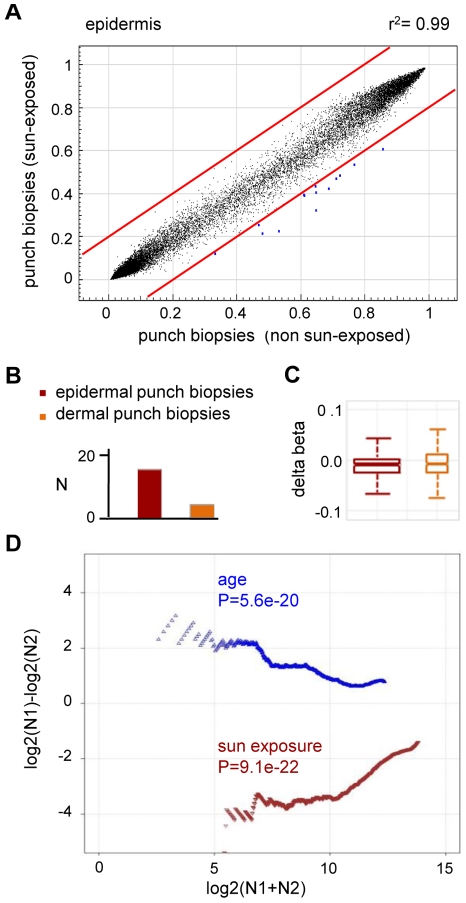
Sun exposure-related hypomethylation.(A) Average epidermal DNA methylation profiles of the study population were compared between 10 sun-exposed and 10 non-exposed epidermis samples. The results reveal a distinct trend towards sun exposure-related hypomethylation. (B) Barplot illustrating the results from an independent statistical analysis of the array data. Bars indicate the number of substantially hypomethylated (Δ(beta)≤−0.2, P(BH)<0.01) markers. (C) Boxplot illustrating sun exposure-related methylation changes in human epidermis and dermis samples. (D) RS (ratio-over-sum) plot illustrating global age-related (blue) and sun exposure-related (brown) methylation shifts in epidermis samples. Points were plotted after Benjamini-Hochberg correction and P-values were obtained after comparisons to Gaussian distributions of randomly generated methylation differences.